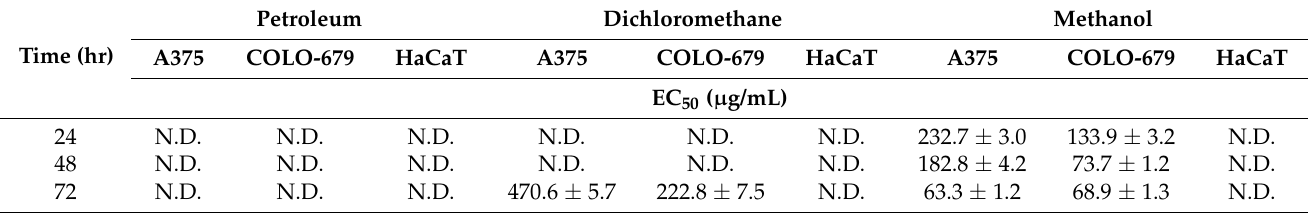
Table 3. Determination of EC 50 values (expressed as µ g/mL) for all cell lines at each time point of